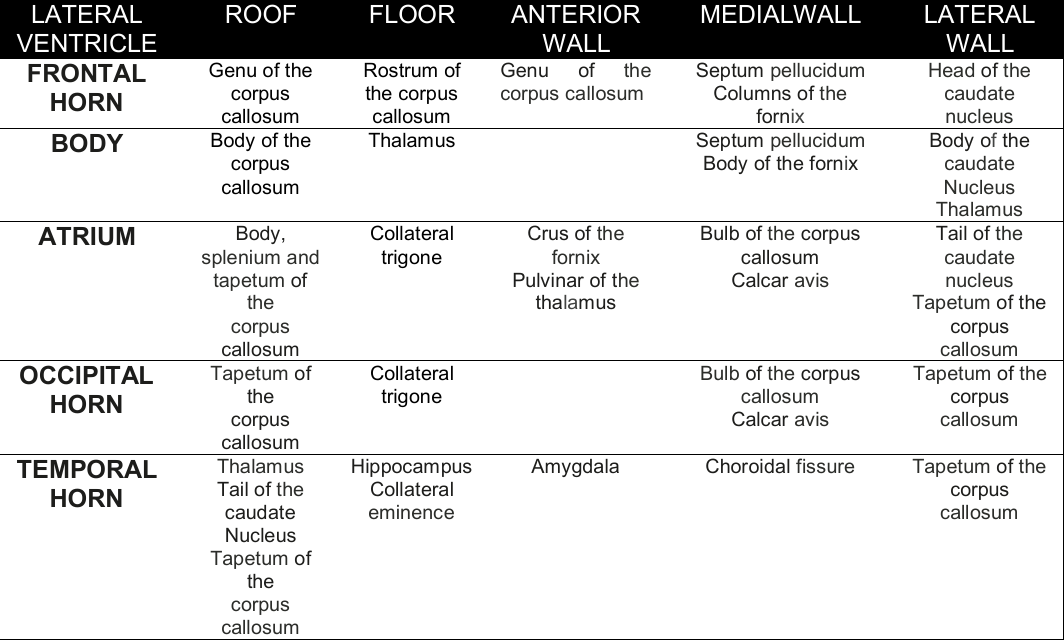
Table 1. Regions and limits of the lateral ventricle.